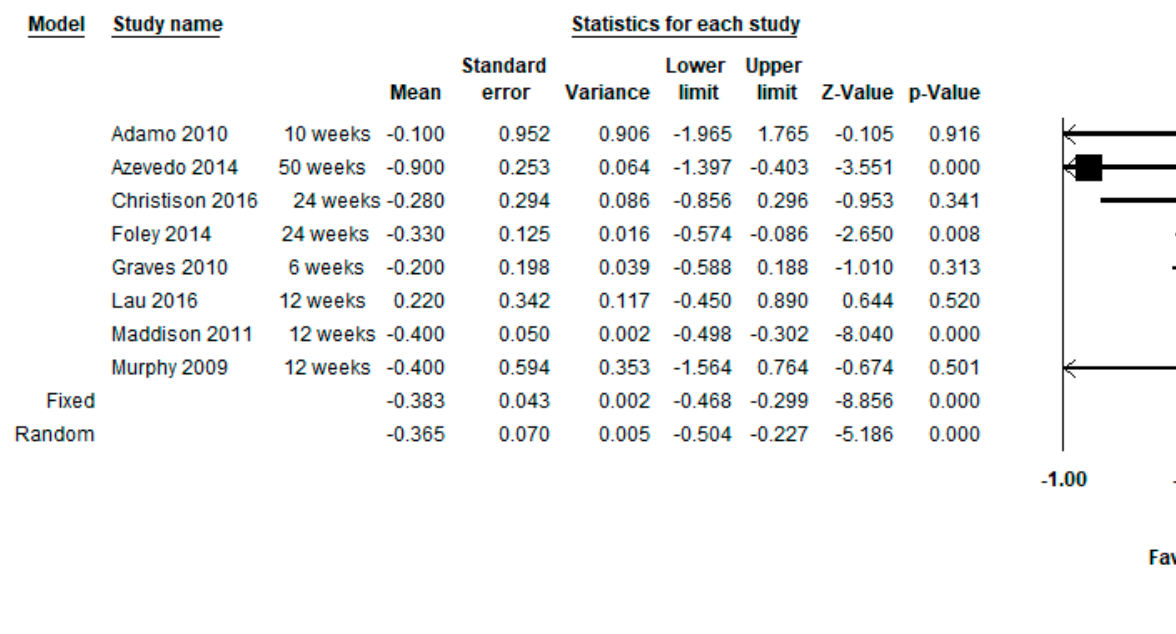
ff erence of BMI between groups. Only BMI (Kgr / m 2 ) in the shortest Figure 10. Pre-post difference of BMI between groups. Only BMI (Kgr/m 2 ) in the shortest follow-up. Figure 10. Pre-post di